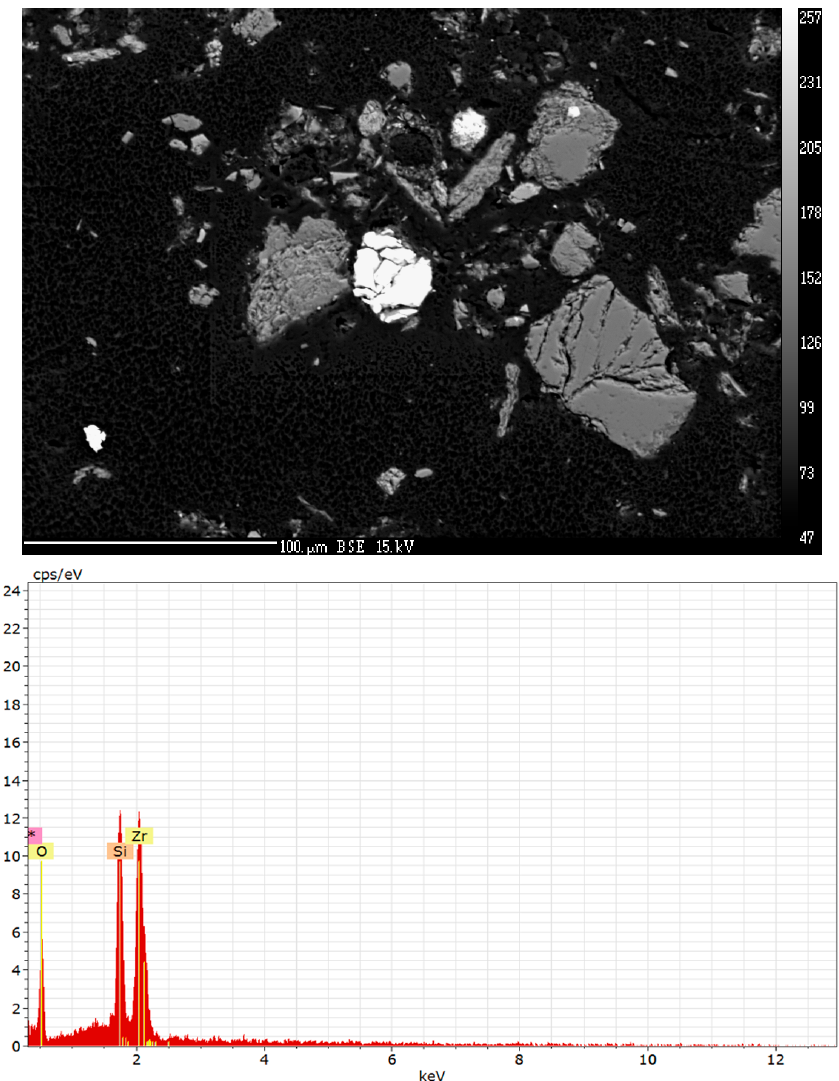
Figure 6. A close-up BSE image of the zircon grain (above) and EDS analysis (below). The star indicates a peak of the C which is coming from the carbon coating of the sample. Sample RIC 3.